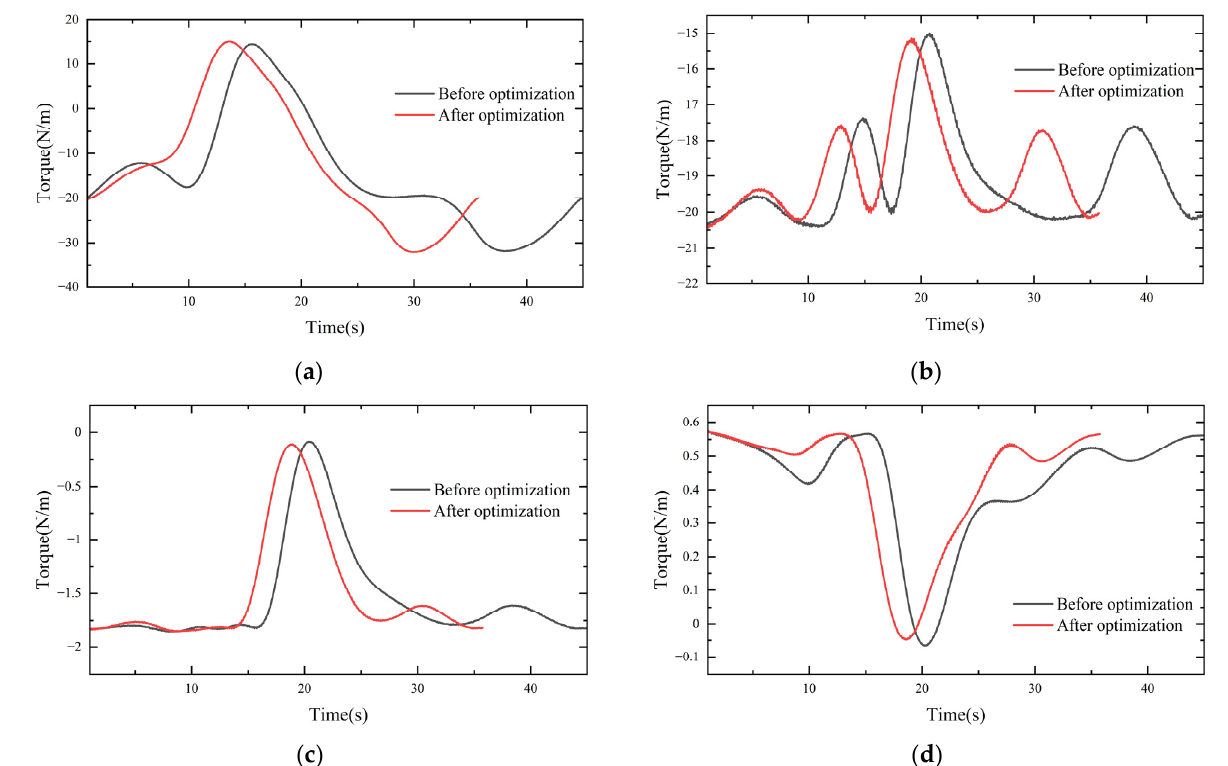
Figure 12. Experimental comparison of joint torque curves: ( a ) joint two; ( b ) joint three; ( c ) joint four; ( d ) joint fi ve.